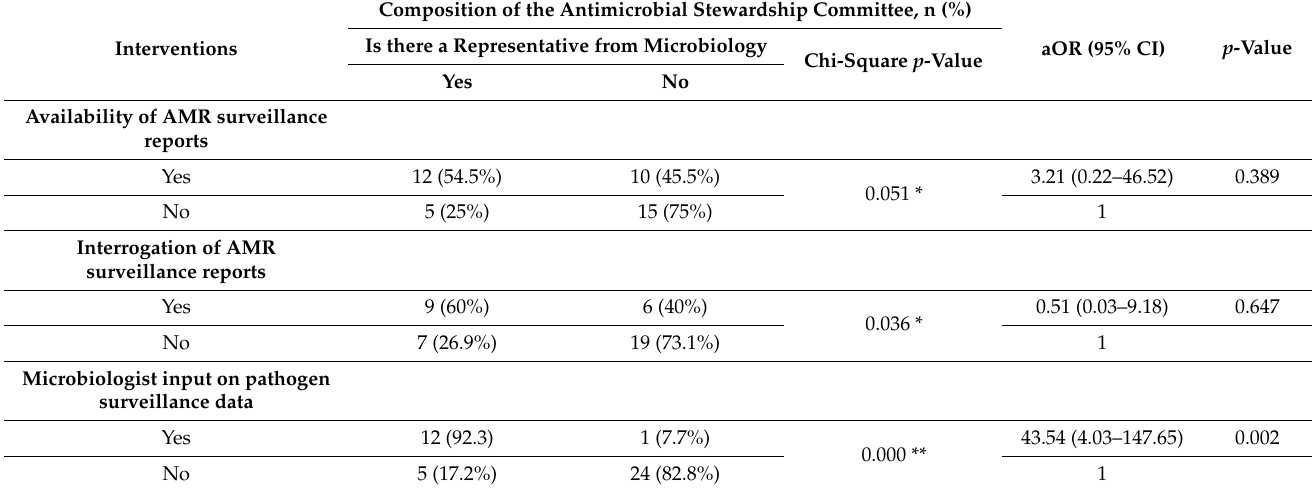
Table 3. Bivariate Chi-squared test of association and multivariable logistic regression: associa- tions between composition of the antimicrobial stewardship committee (clinical microbiologist) and different AMS